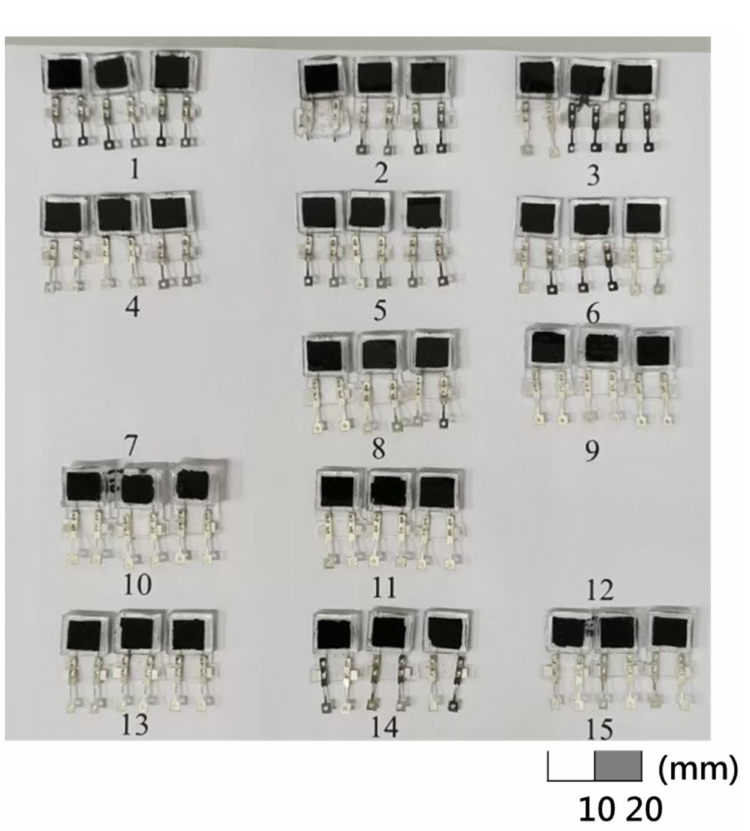
Figure 16. Picture of sensors in experiments 1–15 of different grid structure design.